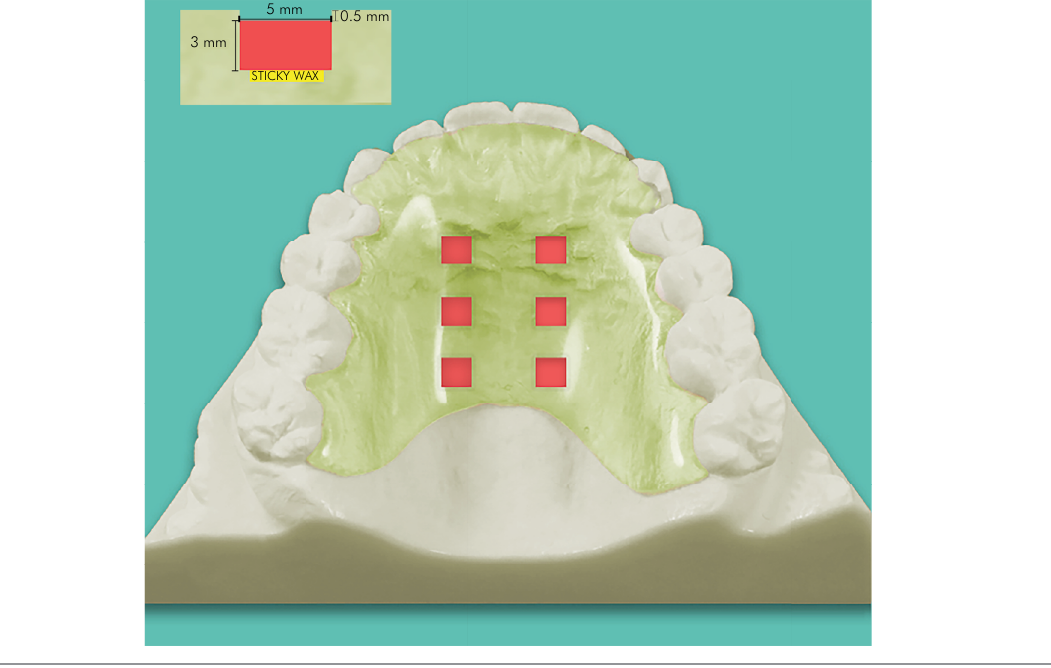
Figure 1. Palatal device with specimens secured with sticky